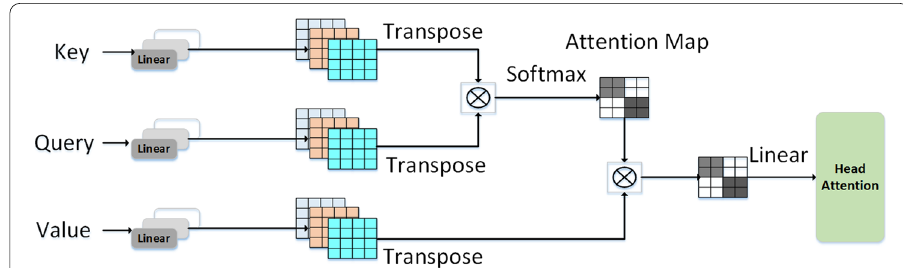
Fig. 4 Attention